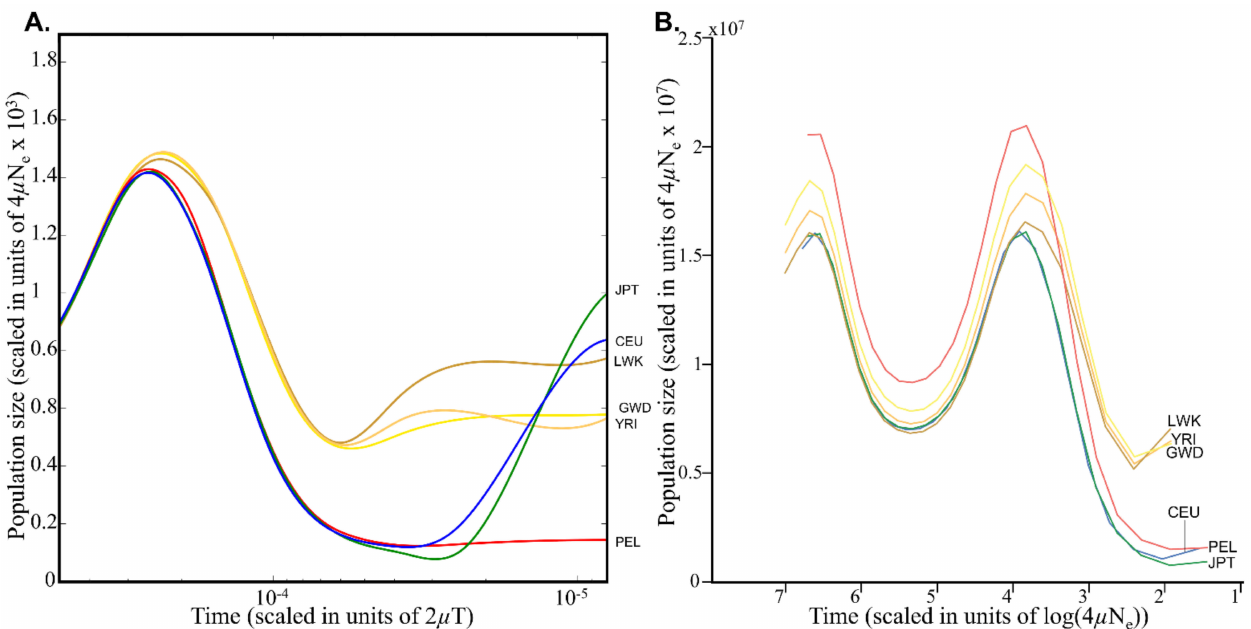
Figure 1. Population structure and demography. Changes in population size over time for six populations. ( A ) Changes to the effective population sizes over time in six populations inferred by PSMC. Lines represent the within-population median PSMC estimate, smoothed by fitting a cubic spline passing through bin midpoints. The original figure was published by Auton et al. (The 1000 Genomes Project Consortium 2015, Figure 2). This figure was created using code and data provided by Dr. Adam Auton to include only the relevant populations. The plot is log-scaled for the X -axis. ( B ) Plotting the Schrider and Kern’s [4] data for the Auton et al.’s figure. Schrider and Kern (2017) sampled 26 data points from ( A ) and scaled them by θ and N 0 . We θ -scaled the X -axis (to get each population on the same timescale) and log-scaled it to increase the similarity with ( A